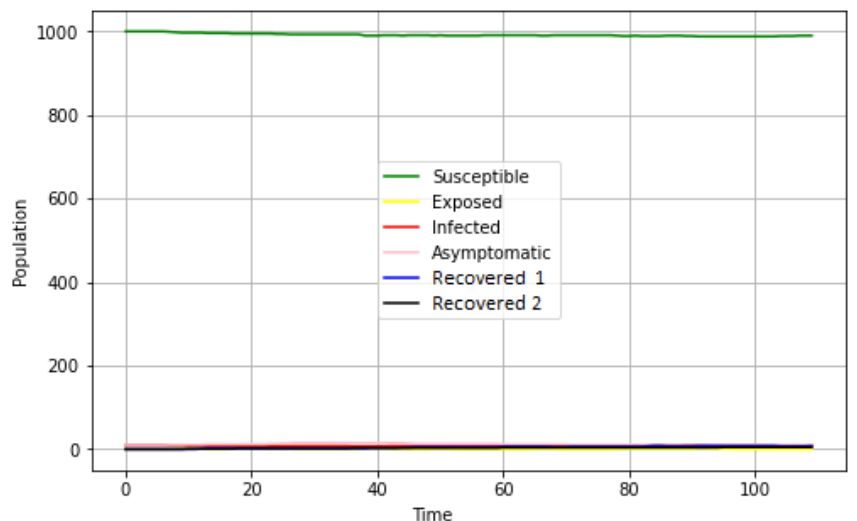
Figure 9. Dynamics of COVID-19 according to the radius of contamination equal to 1 m.